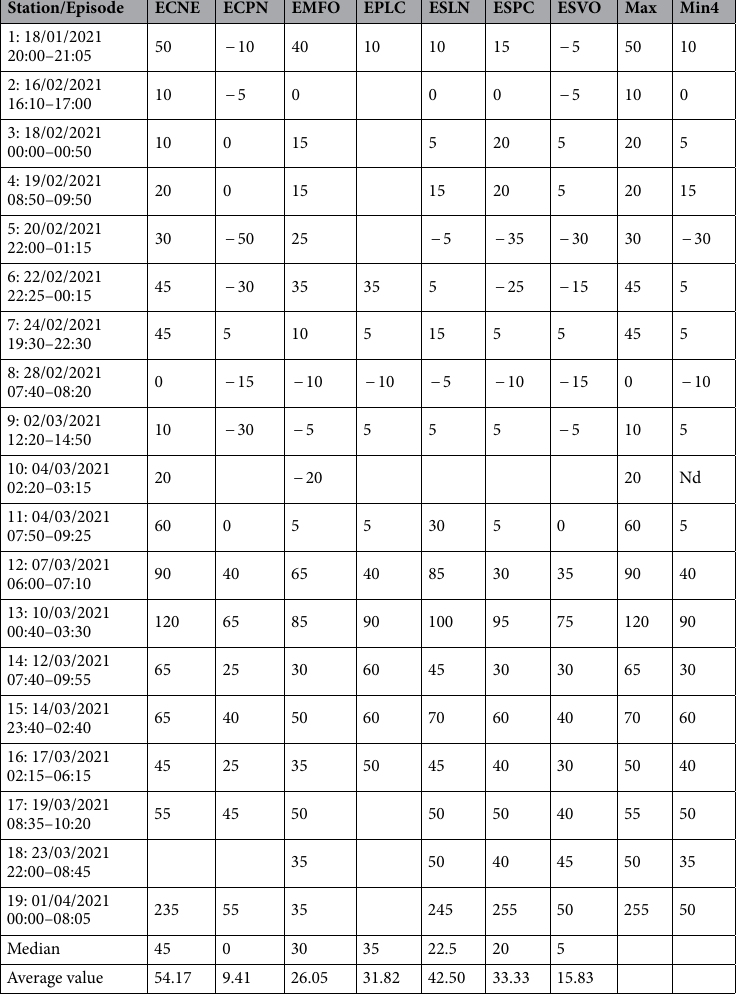
Table 2. Lead times per station. Column “Max” is the maximum lead time encountered. Column “Min4” corresponds to a lead time requesting a minimum of four triggering stations. Values are obtained for a threshold R =